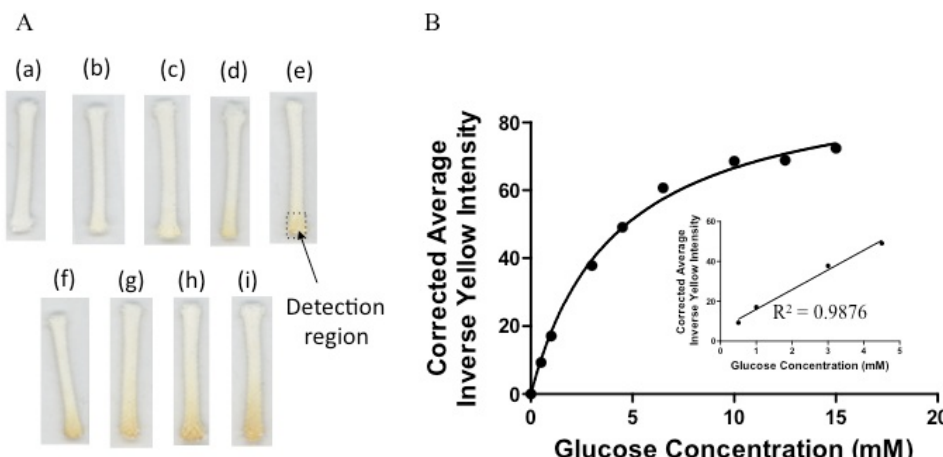
Figure 3. ( A ) Images of increasing concentrations of glucose: ( a ) 0.00 mM, ( b ) 0.50 mM, ( c ) 1.00 mM, ( d ) 3.00 mM, ( e ) 4.50 mM, ( f ) 6.50 mM, ( g ) 10.0 mM, ( h ) 12.5 mM, ( i ) 15.0 mM. ( B ) Corrected average inverse yellow intensities as a function of glucose concentration for the µCAD. Data are presented as the average ± SD from three independent measurements. The error bars reflect the standard deviations from the average values.